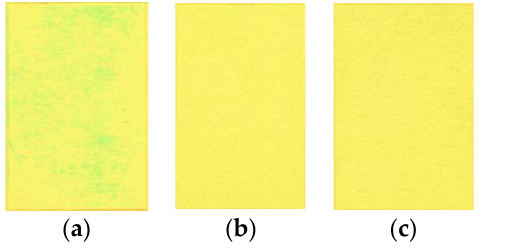
Figure 11. ( a ) Feature image of 1060; ( b ) Feature image of 5052; ( c ) Feature image of 6061.